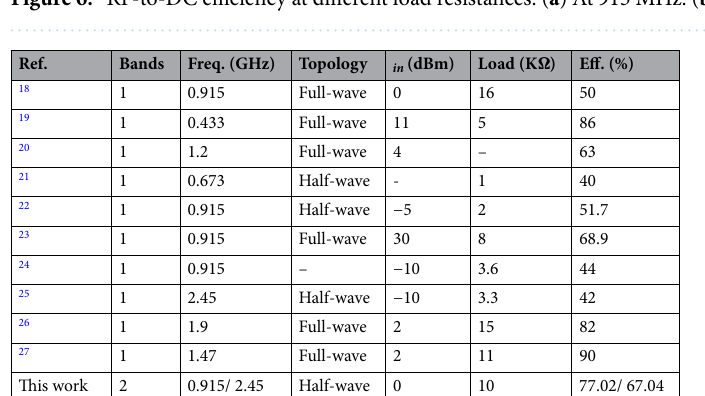
Figure 6. RF-to-DC efficiency at different load resistances. ( a ) At 915 MHz. ( b ) At 2.45 GHz.